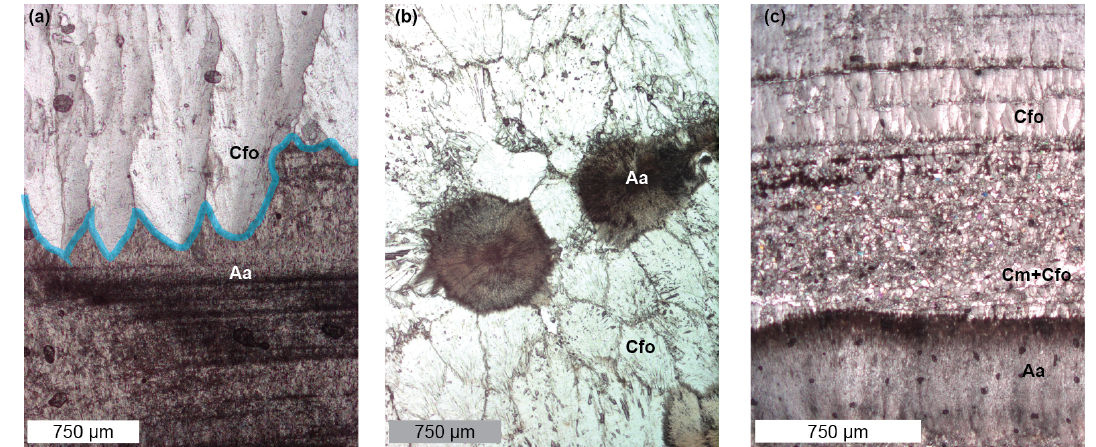
Figure 2. Aragonite and calcite textures. (a) Boundary of fascicular optic calcite (Cfo) and acicular aragonite (Aa), showing competing crystal growth between the two polymorphs (blue line, sample LAS 2). (b) Co-precipitation of primary calcite and aragonite (sample LAS 21). (c) Complex fabric dominated by mosaic calcite (Cm) where fascicular optic calcite polycrystals (Cfo) are locally present between acicular aragonite (Aa) and fascicular optic calcite (Cfo, sample LAS 34). Table 1. Stable isotope composition of the Vinschgau flowstones. δ 18 O (‰) δ 13 C (‰) Sample Mineralogy Min. Max. Mean Min. Max. Mean TR LAS 1 calcite–aragonite − 12.8 − 11.1 LAS 2 calcite–aragonite − 13.0 LAS 21 calcite–aragonite